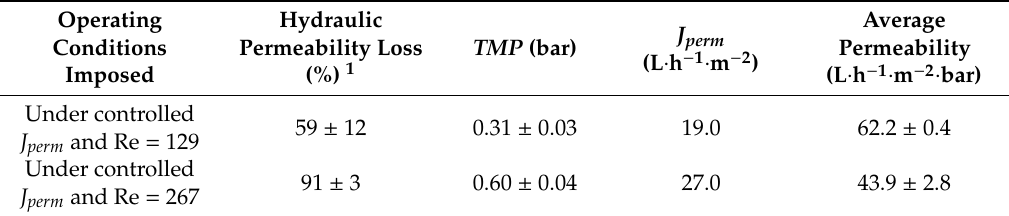
Table 4. E ff ect of the Reynolds number at the feed compartment on the purification of the (diluted) arabinoxylans fraction by dia-ultrafiltration operated without relaxation procedure, under controlled conditions of permeate flux J perm of 19 L · h − 1 · m − 2 and at 40 ◦ C: hydraulic permeability loss